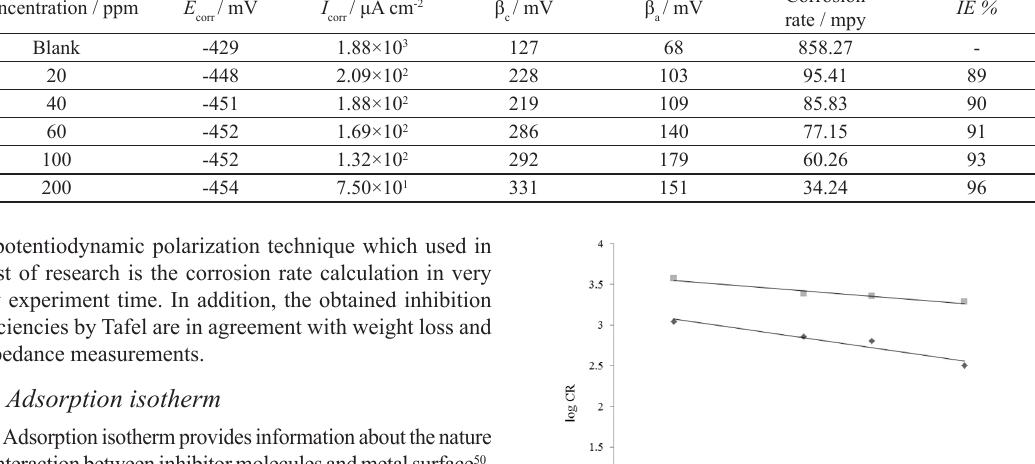
Table 3. Tafel polarization curves for mild steel in 1N HCl and 1N H Concentration / ppm